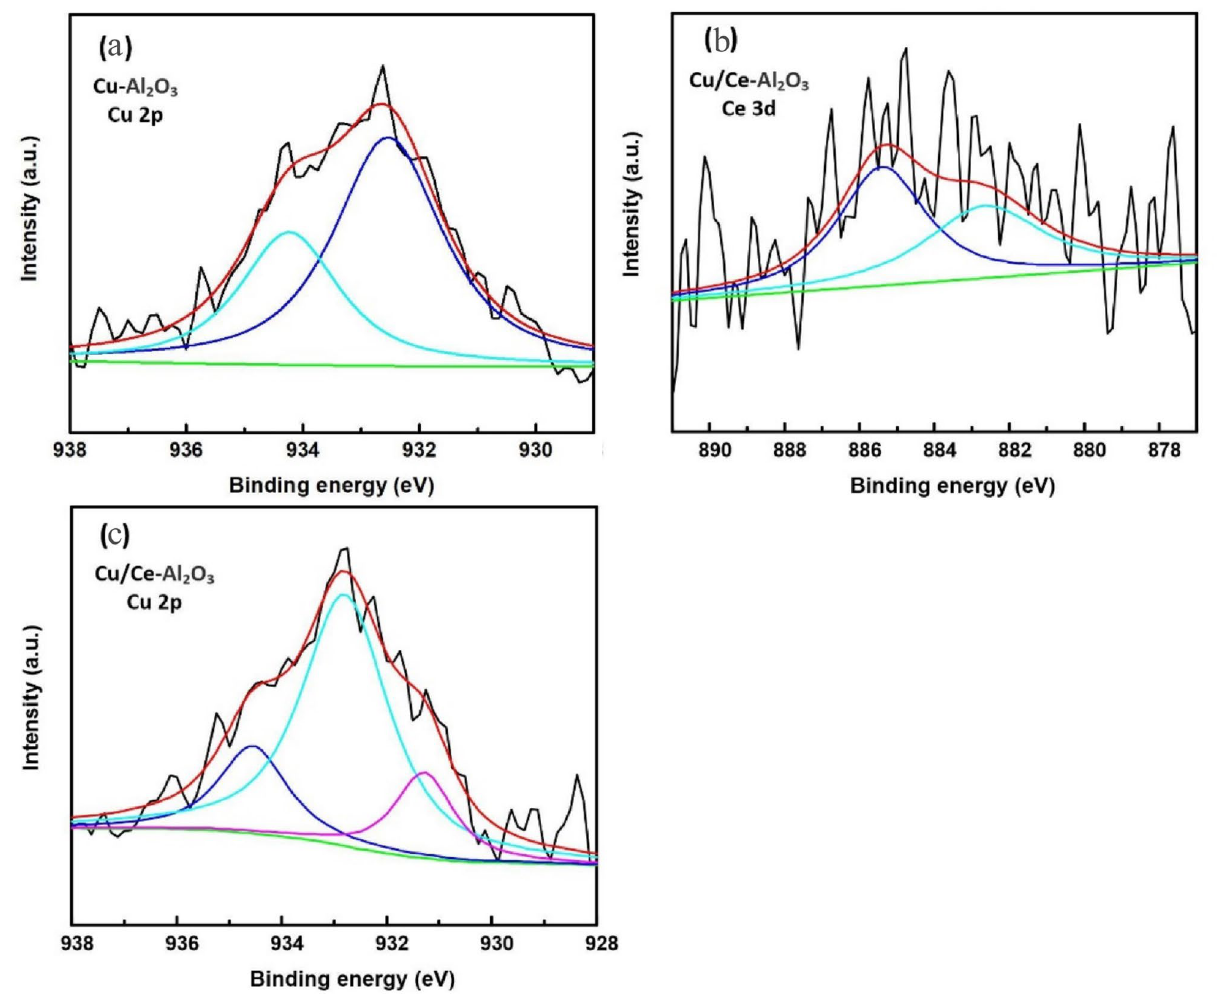
Figure 1. Full-range XPS spectra of catalysts: ( a ) Cu–Al 2 O 3 Cu 2p, ( b ) Cu/Ce–Al 2 O 3 Cu 2p and ( c ) Cu/Ce– Al 2 O 3 Ce